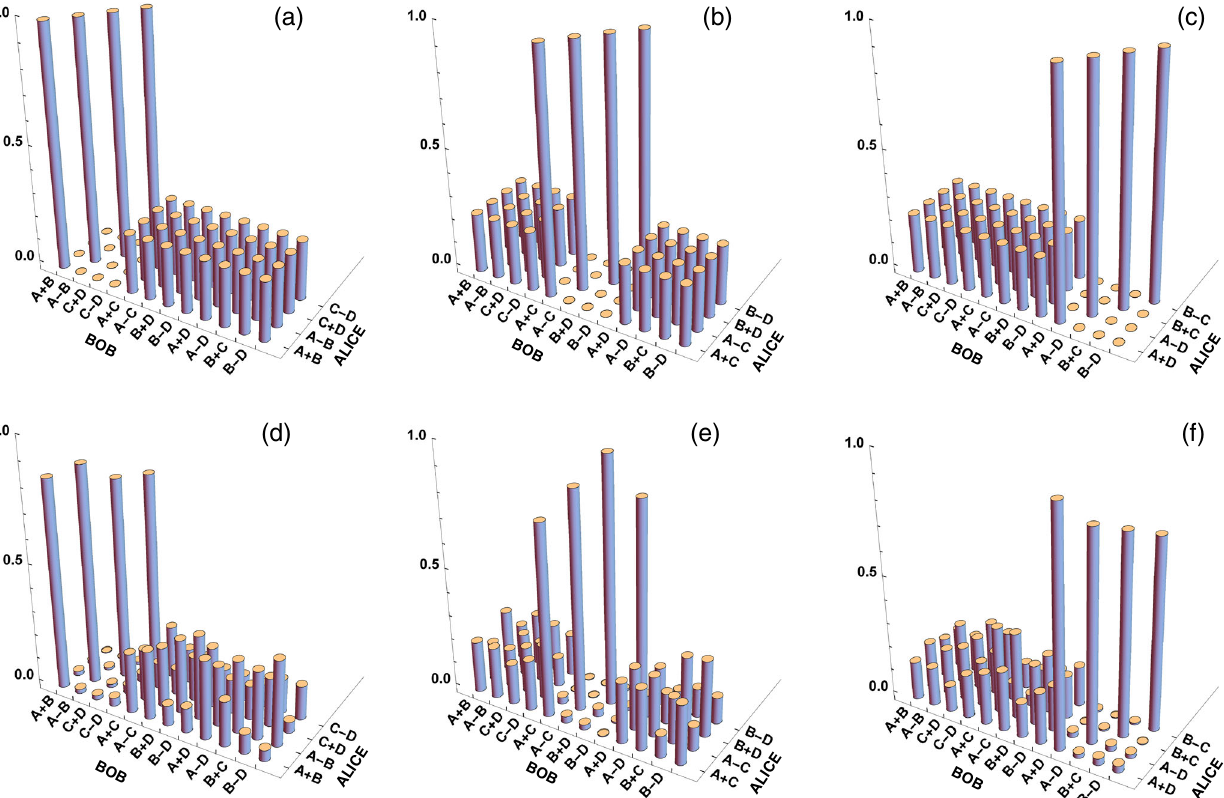
Fig. 3 State tomography of the three MUBs: a , b , c represent the theoretical matrices of the different MUBs; d , e , f show the experimental measurements of the same basis. The state tomography were obtained with 30 s of integration time using a CW 1550 nm laser modulated with a 10 ns pulse at 10 kHz of repetition rate and a mean photon per pulse of 0.2 ± 0.006. By using the (classical) de fi nition of fi delity ( F ( x , y ) = ∑ 1/2 , where x and y are random variables and q i ( p i q i ) i and p i are the vector of probability distribution), we obtain an average ±